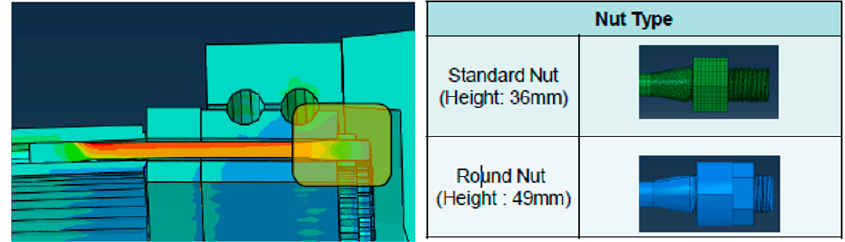
Figure 10. Finite element model (two-dimensional (2D) and 3D model).